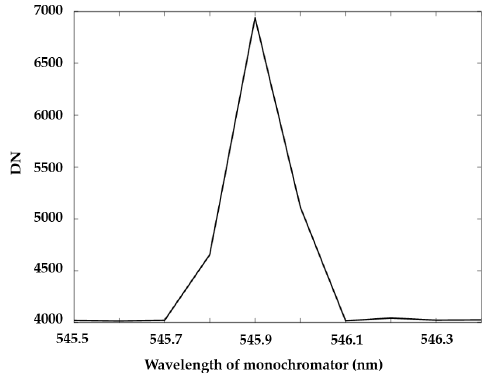
Figure 9. Monochromator’s response for 546 nm standard spectral line of mercury lamp (error of monochromator is 0.08 nm).